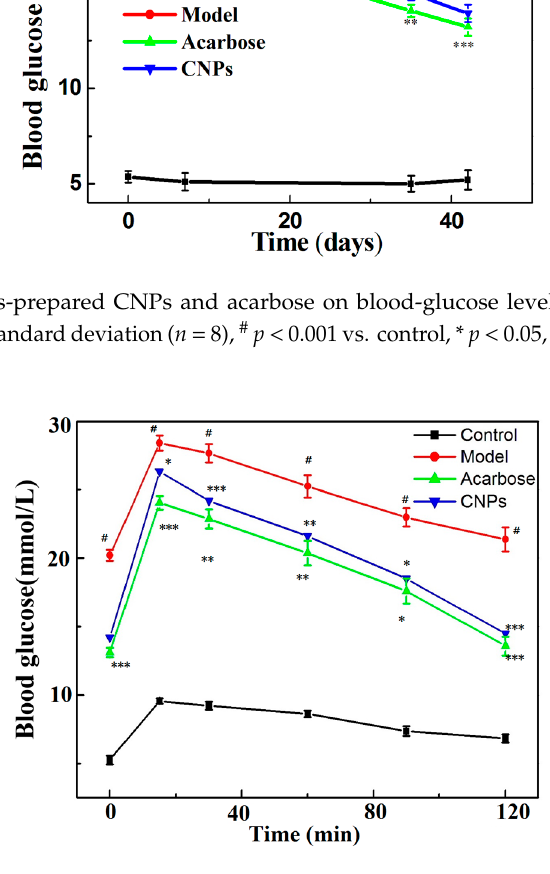
Figure 5. Effects of the as ‐ prepared CNPs and acarbose on glucose tolerance in mice. Each value is expressed as mean ± standard deviation ( n = 8), # p < 0.001 vs. control, * p < 0.05, ** p < 0.01, *** p < 0.001 vs. model.